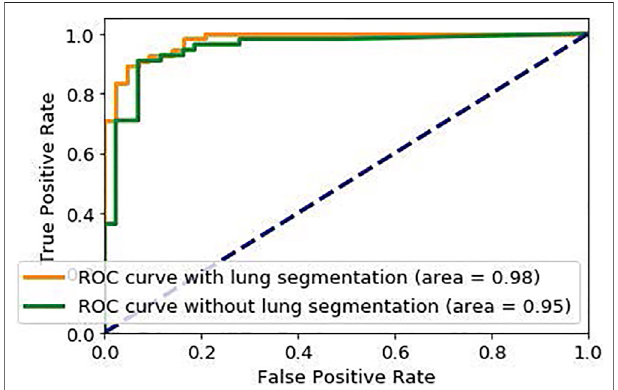
FIGURE 5 | ROC curve of the proposed